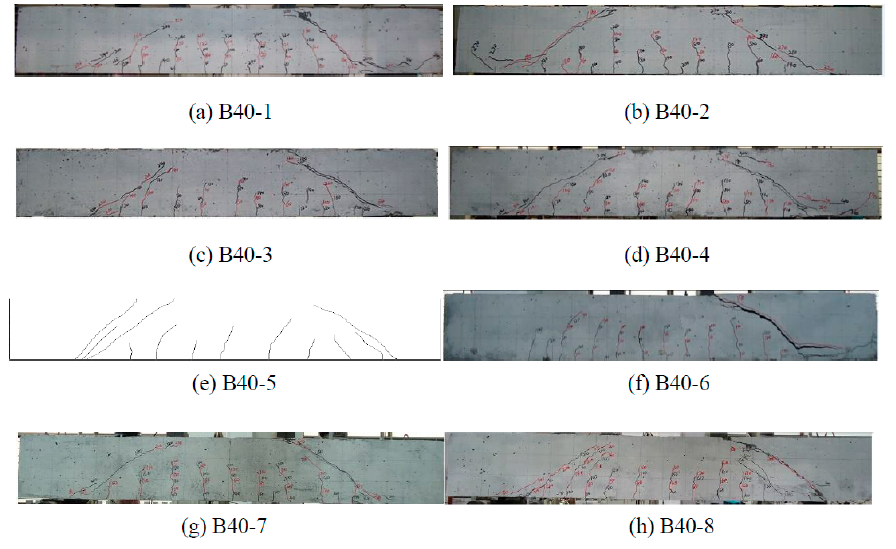
Figure 6. Failure mode of C40 grade concrete beams.